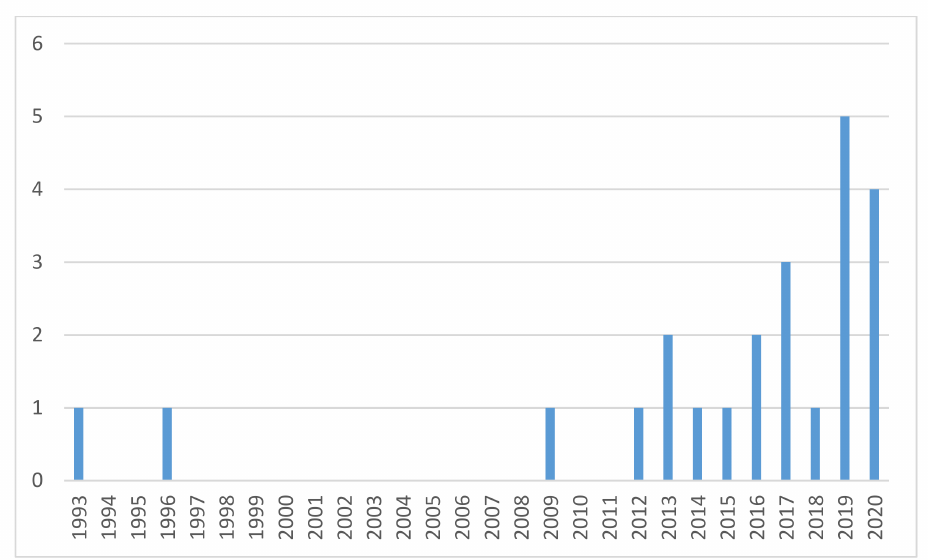
Figure 3. Number of families identified with ATTRv in recent years ( n =